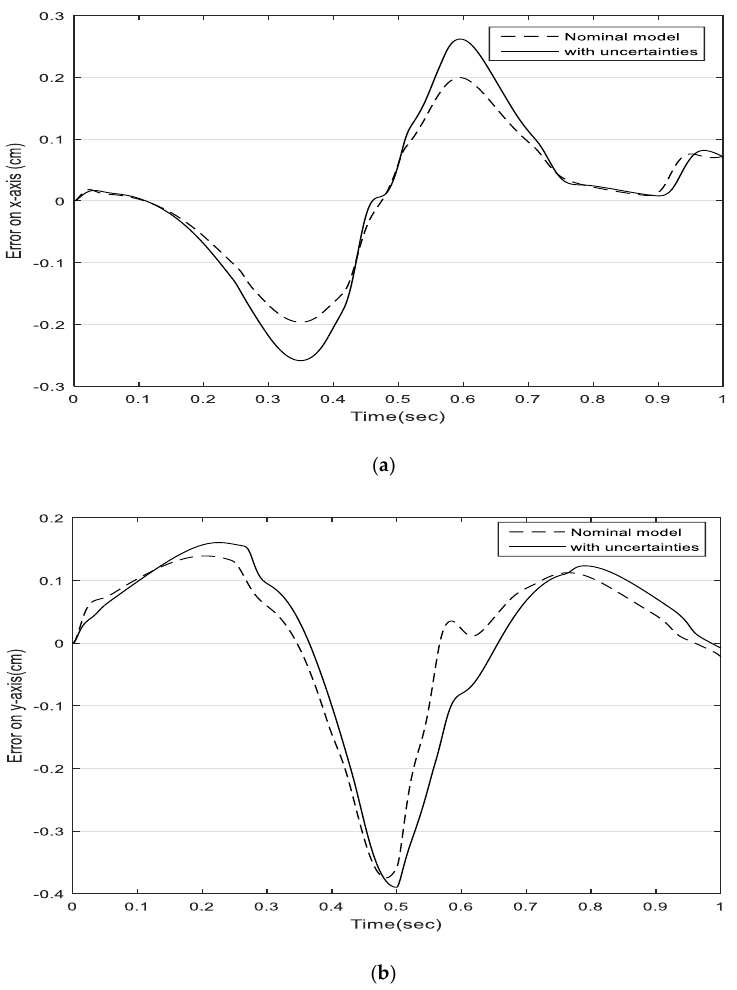
Actuators 2021 , 10 , x FOR PEER REVIEW Figure 11. Effect of model uncertainties on NCGPC tracking errors: ( a ) X-axis; ( b ) Y-axis.